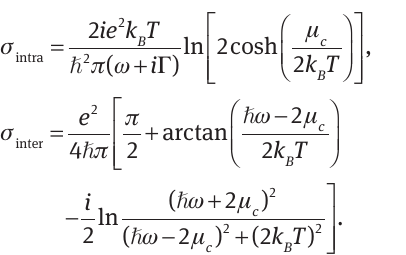
and (C) silicon permittivity ε c Si